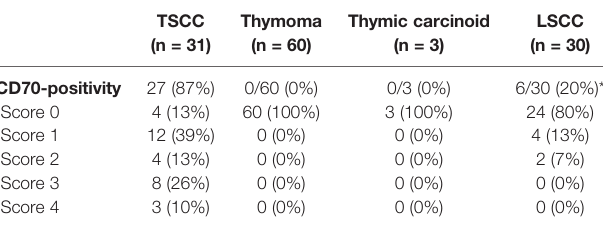
TABLE 2 | Immunohistochemical analysis of CD70 in surgical specimens.